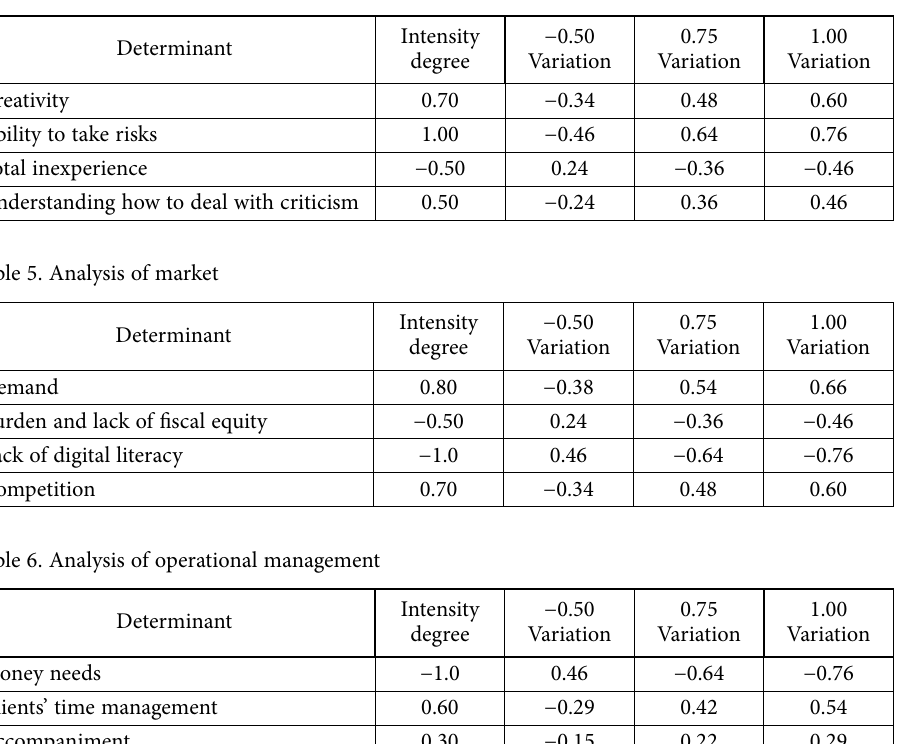
Table 4. Analysis of entrepreneur profile